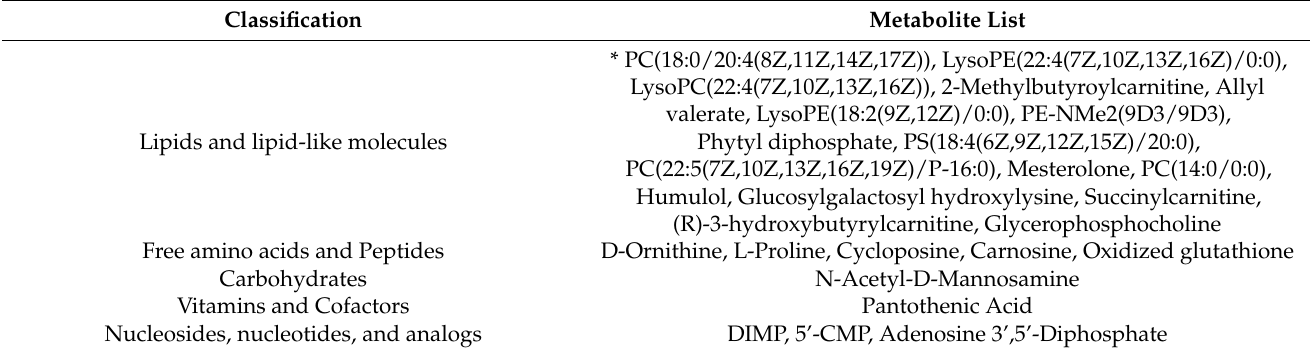
Figure 3. Metabolome analysis of leg muscle from different rearing conditions. “Ca” refers to the cage rearing group, and “Fr” refers to the cage-free rearing group. ( A ) OPLS-DA score plot of metabolites in leg muscle samples. “Dot” refers to the cage rearing group, and “triangle” refers to the cage-free rearing group. ( B ) The permutation tests of data; the Y axis refers to similarity. ( C ) Volcano plot of differentially expressed metabolites. The X-axis refers to the log2-fold change, and the Y-axis refers to − log10 ( p value). The red dots and blue dots represent the upregulated and downregulated metabolites, respectively. ( D ) The heatmap of the top 200 differential metabolites. Different colors refer to different expression levels. ( E ) The KEGG pathway analysis of differential metabolites. The X-axis refers to the p value and the Y-axis refers to different pathways. Table 4. Metabolites potentially related to flavor compounds and flavor